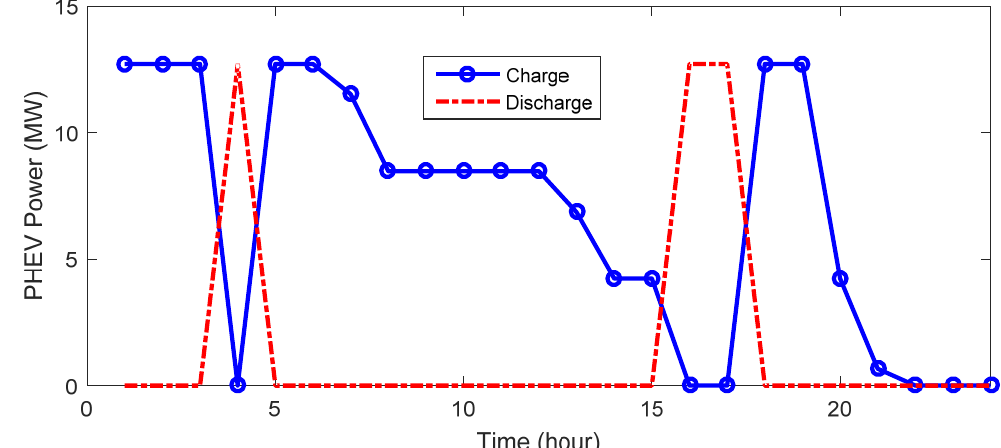
Figure 14. Charging and discharging of electric parking lot batteries with and without OSPF via the AOA for 24 h.